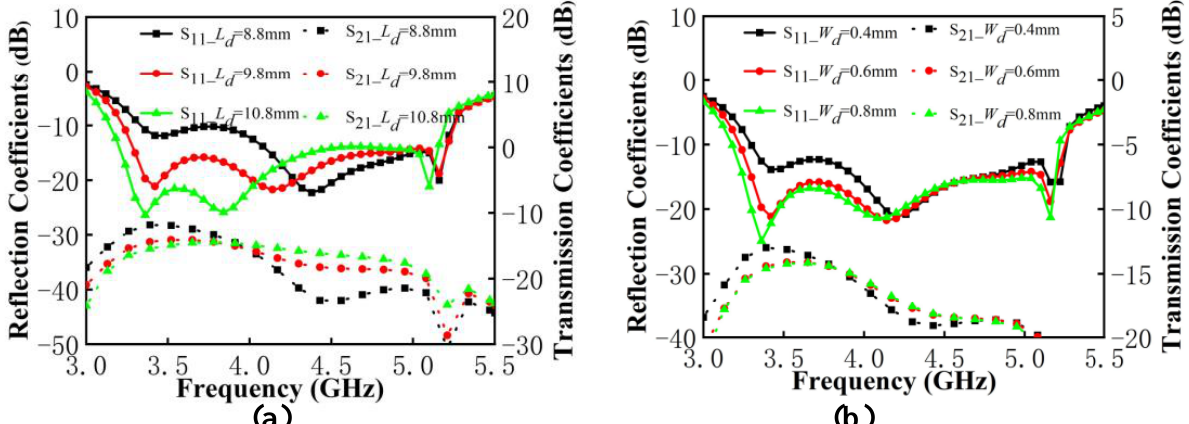
Figure 11. ( a ) S-parameters of the proposed antenna pairs with different values of L d . ( b ) S-parameters of the proposed antenna pairs with different values of W d